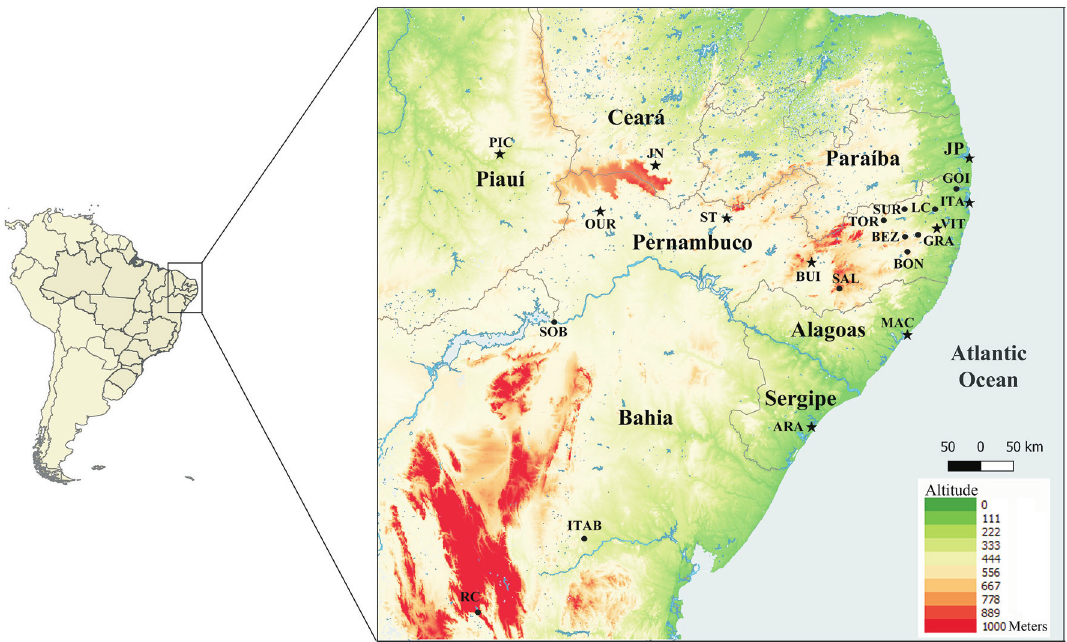
Figure 1 - Partial map of the Brazilian Northeast indicating the sampling locations of Rhammatocerus brasiliensis populations. Aracaju (ARA) – SE; Maceió(MAC)–AL;JoãoPessoa(JP)–PB;Itamaracá(ITA)–PE;VitóriadeSantoAntão(VIT)–PE;Goiana(GOI)–PE;Gravatá(GRA)–PE;Bonito (BON) – PE; Toritama (TOR) – PE; Saloá (SAL) – PE; Buíque (BUI) – PE; Lagoa do Carro (LC) – PE; Surubim (SUR) – PE; Bezerros (BEZ) – PE; Serra Talhada (ST) – PE; Ouricuri (OUR) – PE; Juazeiro do Norte (JN) – CE; Picos (PIC) – PI; Sobradinho (SOB) – BA; Itaberaba (ITAB) – BA; and Rio de Contas (RC) – BA. Circles indicate populations with karyotyped individuals. Stars indicate populations with karyotyped individuals also analyzed for population